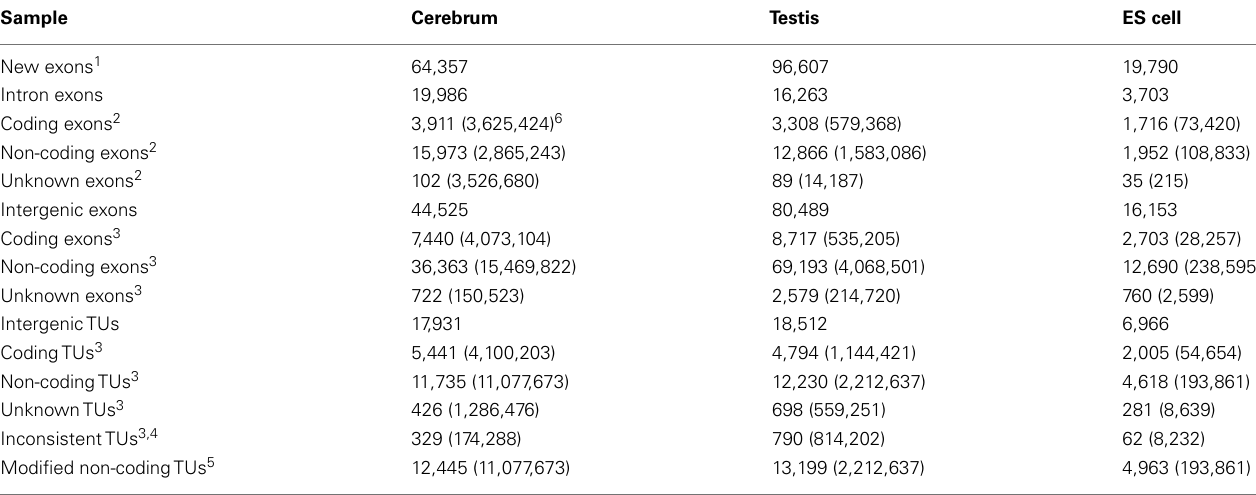
Table 3 | Summary of coding and non-coding exons